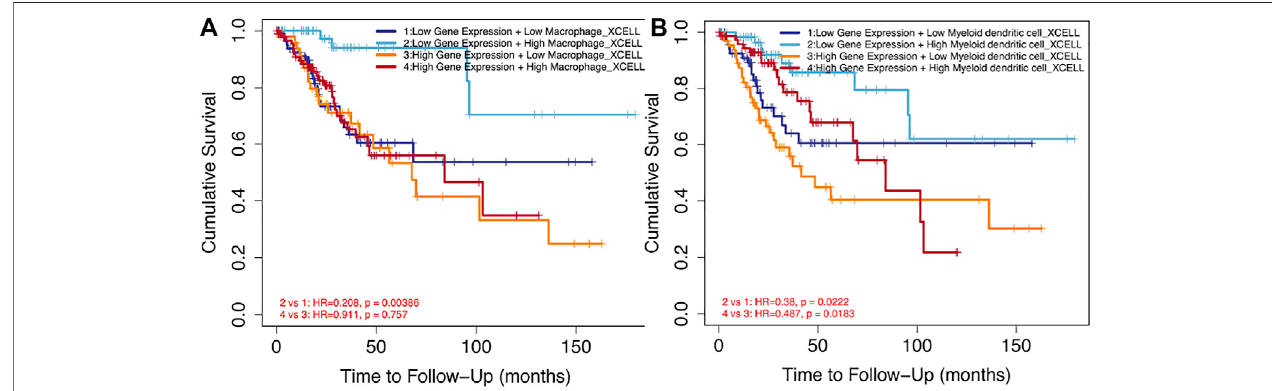
FIGURE 9 | Impact of immune cell in fi ltration on prognosis in cervical cancer patients. (A) Clinical survival outcome of cervical cancer patients in the high- macrophage group. (B) Clinical survival outcome of cervical cancer patients in the high – DC cell group.